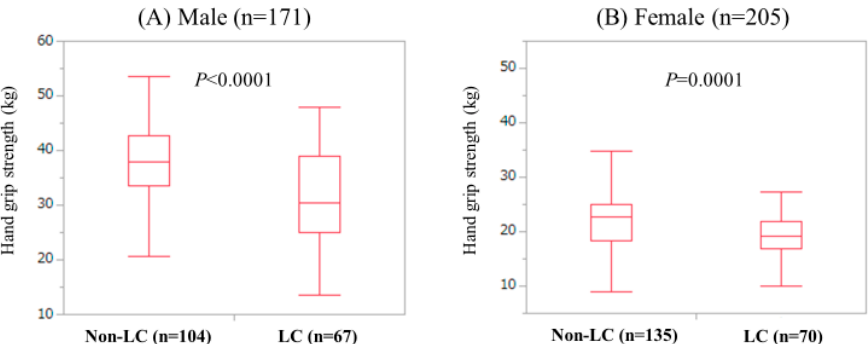
Figure 1. Grip strength (GS) value according to the liver cirrhosis (LC) status in males ( A ) and females ( B ).